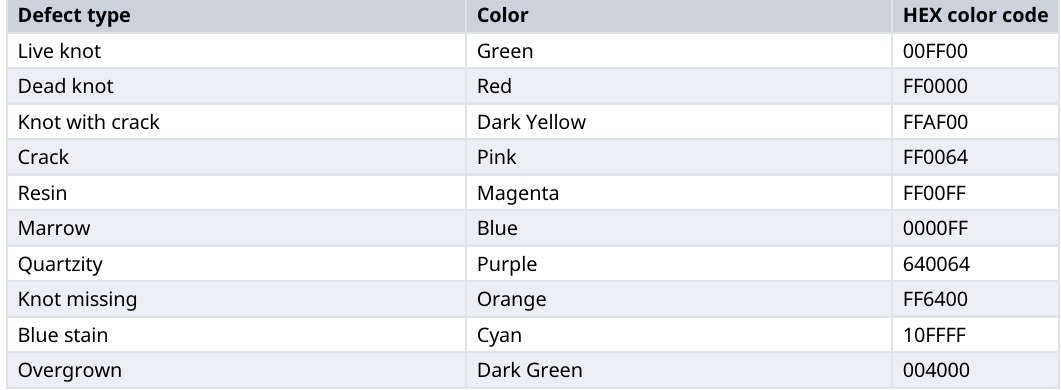
Table 2. Annotation color specification for the provided dataset with hexadecimal color